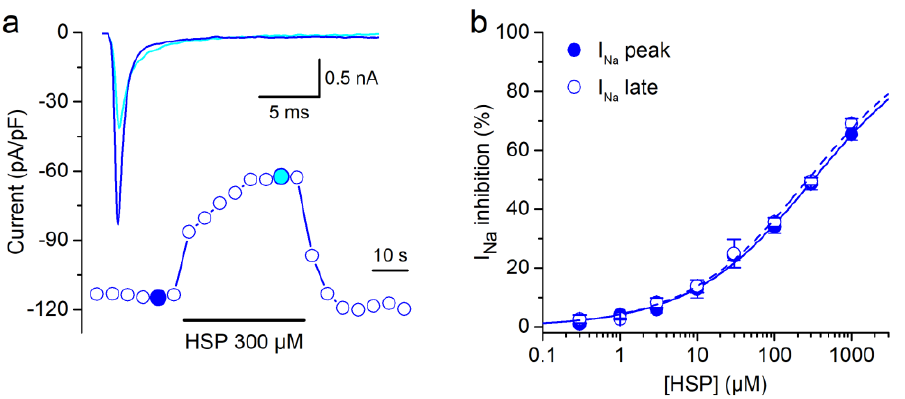
Figure 2. Hesperetin inhibits currents carried by the LQT3 ∆KPQ mutant channels. ( a ) Time course of the I Na recorded in HEK293T cells expressing ∆KPQ hNa V 1.5 in the control condition and in the presence of HSP 300 µM. Note that the effect of HSP was fully reverted upon washout. Representative current traces in control and upon the application of HSP are shown in the inset and correspond with the colored data points. For clarity only the first 25 ms of the current traces are shown. Note that HSP decreased peak I Na but also slowed down its inactivation. ( b ) Concentration–effect curves for the action of HSP on ∆KPQ hNa V 1.5 peak and late currents. The dots represent the mean ± s.e.m. inhibition percentage during the application of different concentrations of HSP ( n = 21). The line represents the Hill fit of the data. Cells were clamped at a holding potential of −100 mV and 50-ms pulses to −20 mV were continuously applied at a rate of 0.25 Hz.